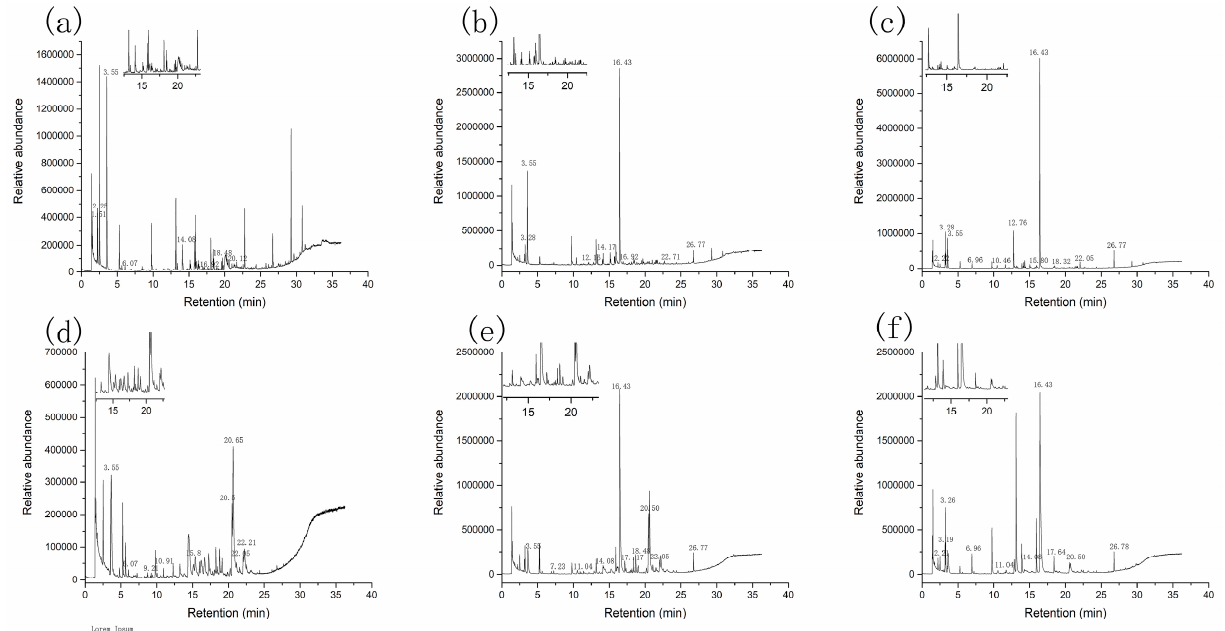
Figure 5. Total ion chromatogram of volatile components: ( a ) HO of crab legs, ( b ) EHS of crab legs, ( c ) MRS of crab legs, ( d ) HO of crab bodies, ( e ) EHS of crab bodies, and ( f ) MRS of crab